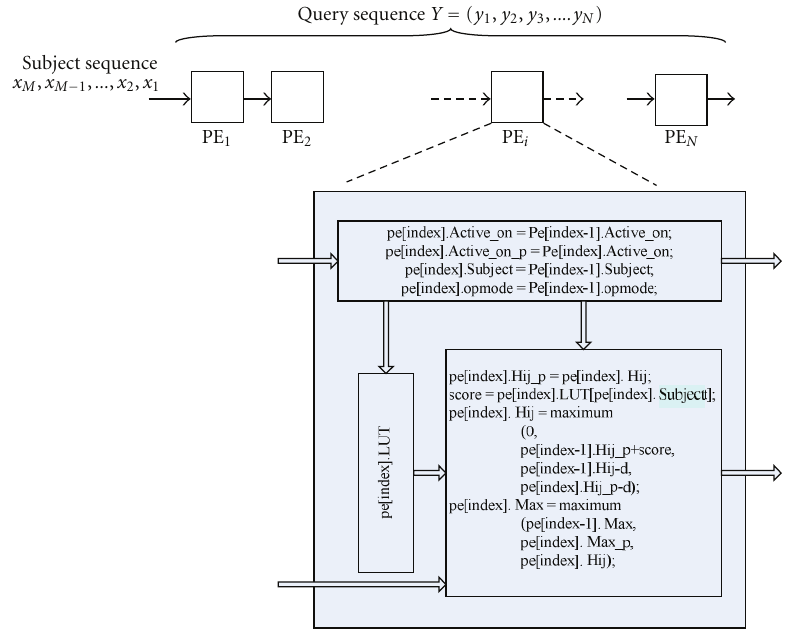
Figure 6: Linear processor array architecture for the FPGA implementation of the Smith-Waterman algorithm.